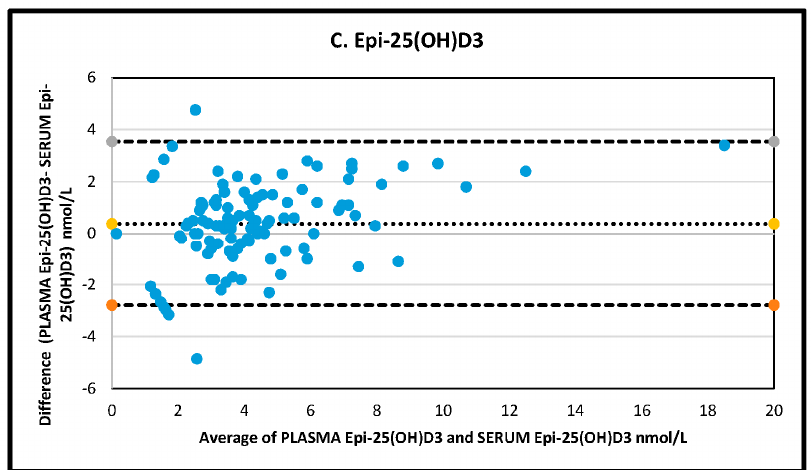
Figure 2. 25(OH)D: 25-hydroxyvitamin D. ( A – C ) Bland-Altman Plot comparison between plasma and serum concentrations of vitamin D analytes quantified using liquid chromatography-tandem mass-spectrometry. ( A ) Total 25-hydroxyvitamin D (25(OH)D), ( B ) 25-hydroxyvitamin D 3 (25(OH)D 3 ) and ( C ) Epi-25-hydroxyvitamin D 3 (25(OH)D 3 ). Dotted line: mean di ff erence (bias); dashed line: upper